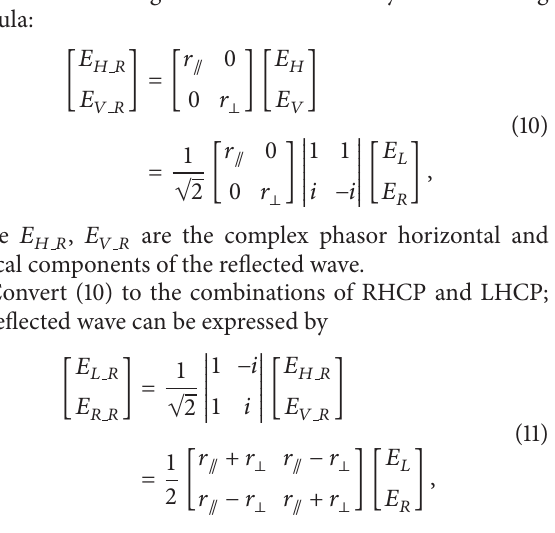
Table 1: Characteristics of dry and wet